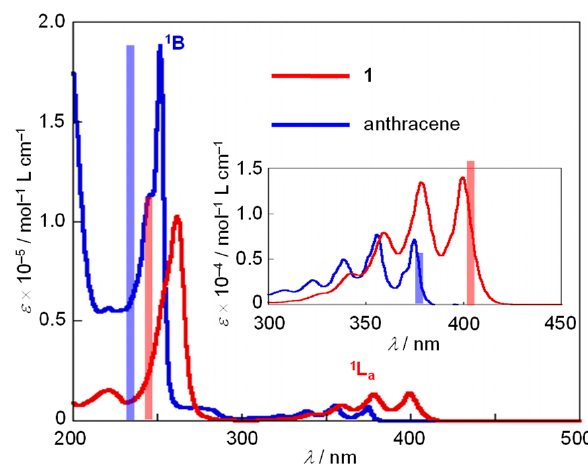
Figure 2. UV/Vis spectra of 1 and anthracene in hexane at room temperature. The pale red ( 1 ) and blue (anthracene) bars denote absorption calculated by using the optimized structures of the S 0 states of 1 and anthracene at the TD-DFT B3LYP/6-31G(d) level. We also measured the fluorescence spectra of 1 and anthracene at 77 K (Figure 3).